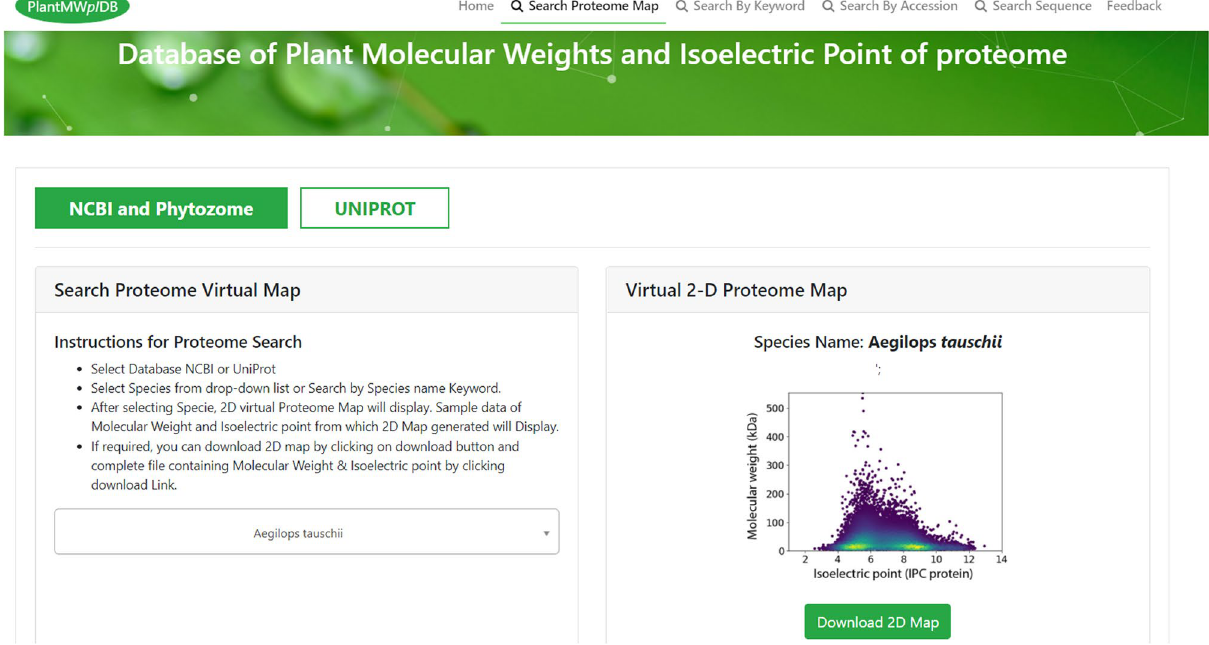
Figure 2. Pictorial presentation of PlantMWpIDB interface. The database shows the search box for the individual species to find the molecular weight and isoelectric point of the plant protein. The user can use